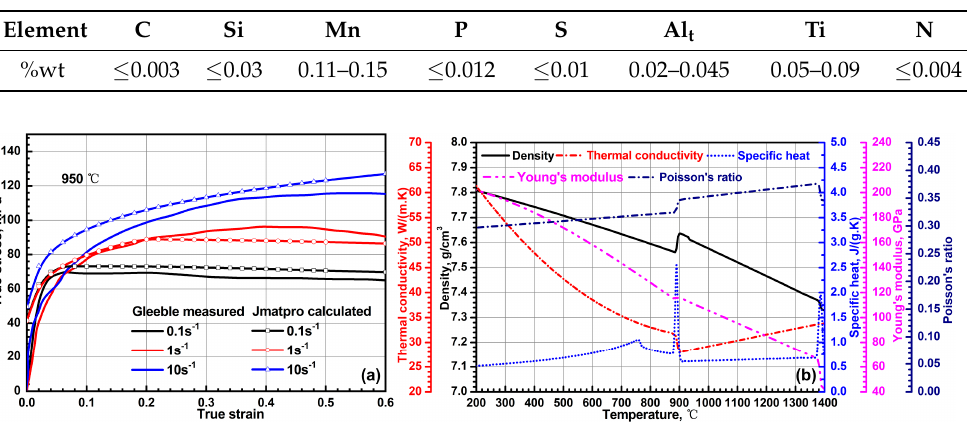
Figure 1. Thermophysical parameters of IF steel used in the calculation: stress–strain curves ( a ) and material parameter–temperature curves ( b ).